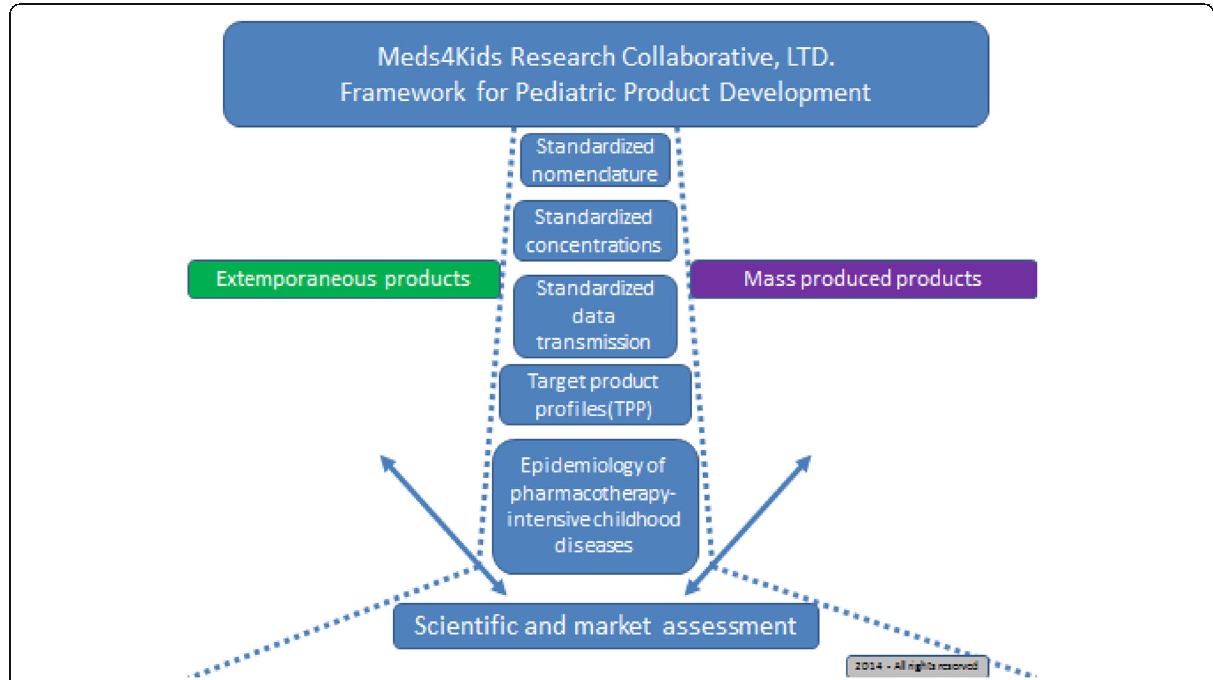
Fig. 1 M4KRC framework for collaborative pediatric drug